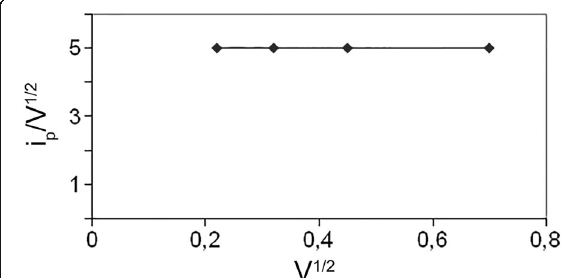
Fig. 3 Dependence i p /V 1/2 from V 1/2 for rhodium cathode vs platinum rod in molten mixture urea-NH 4